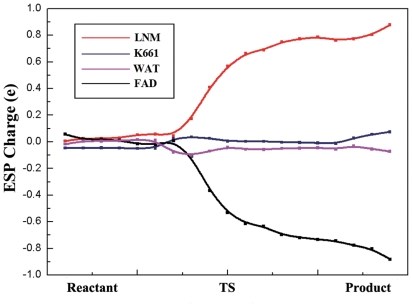
ESP charge distributions of the four groups in the QM region along the hydride transfer reaction.